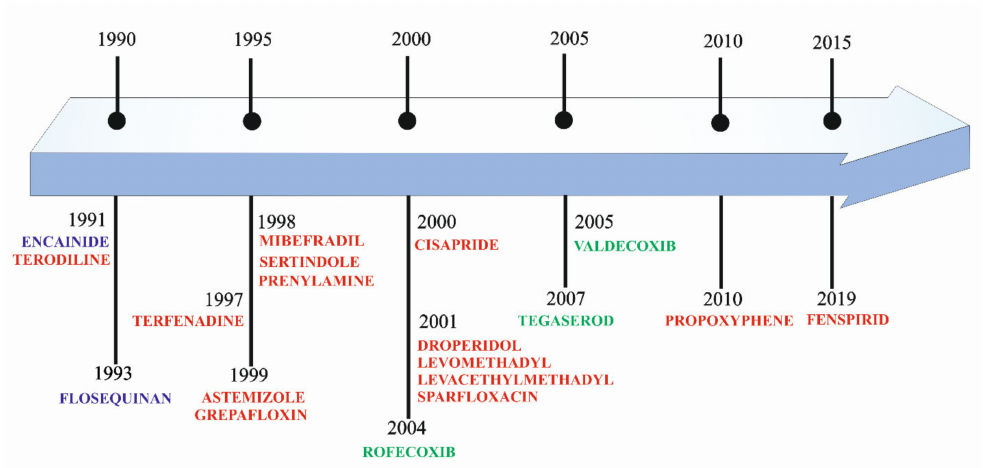
Figure 1. Drugs withdrawn from market due to proarrhythmic e ff ect (purple), myocardial infarction (green), torsadogenic potential, i.e., QT interval prolongation and torsade the points (TdP) e ff ect